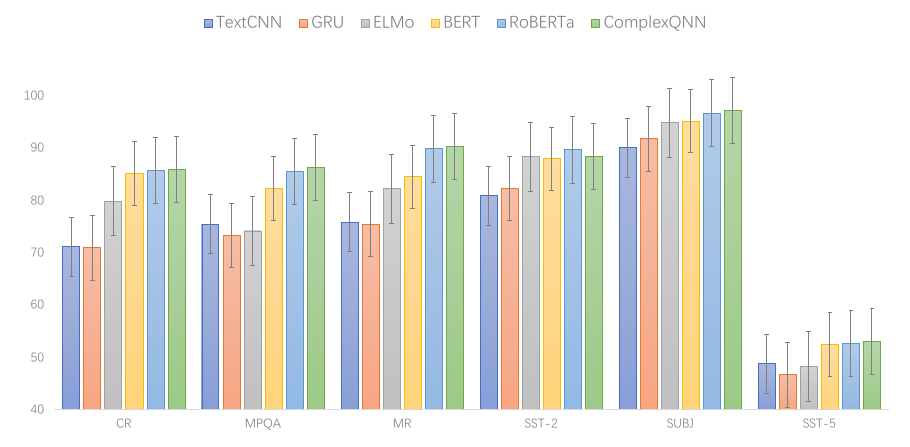
Figure 7. The F1-score results of six models on six sentiment-classification datasets. Table 4. The training time of six models on six sentiment-classification